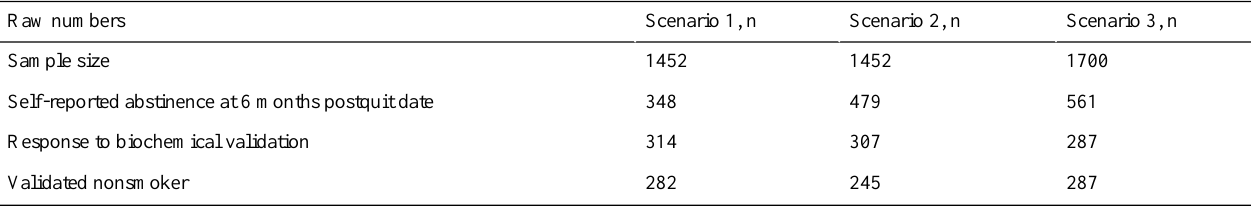
Table 3. Sample size